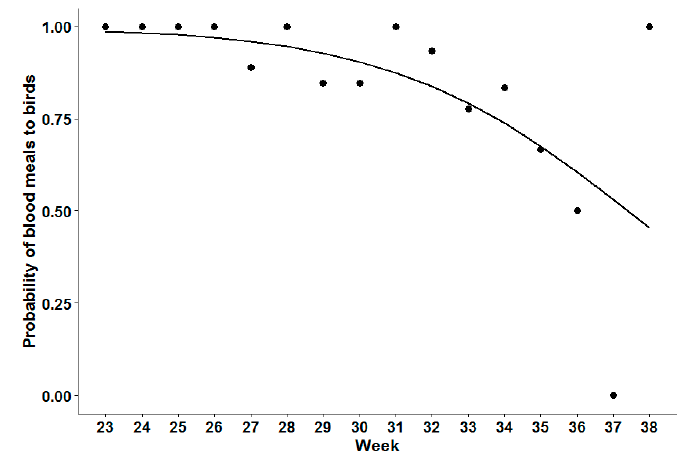
Figure 5. Weekly proportion of Culex pipiens–restuans blood meals taken from birds of all species. Data points correspond to field data and the solid line through the data corresponds to the predicted proportions using the logistic regression model.